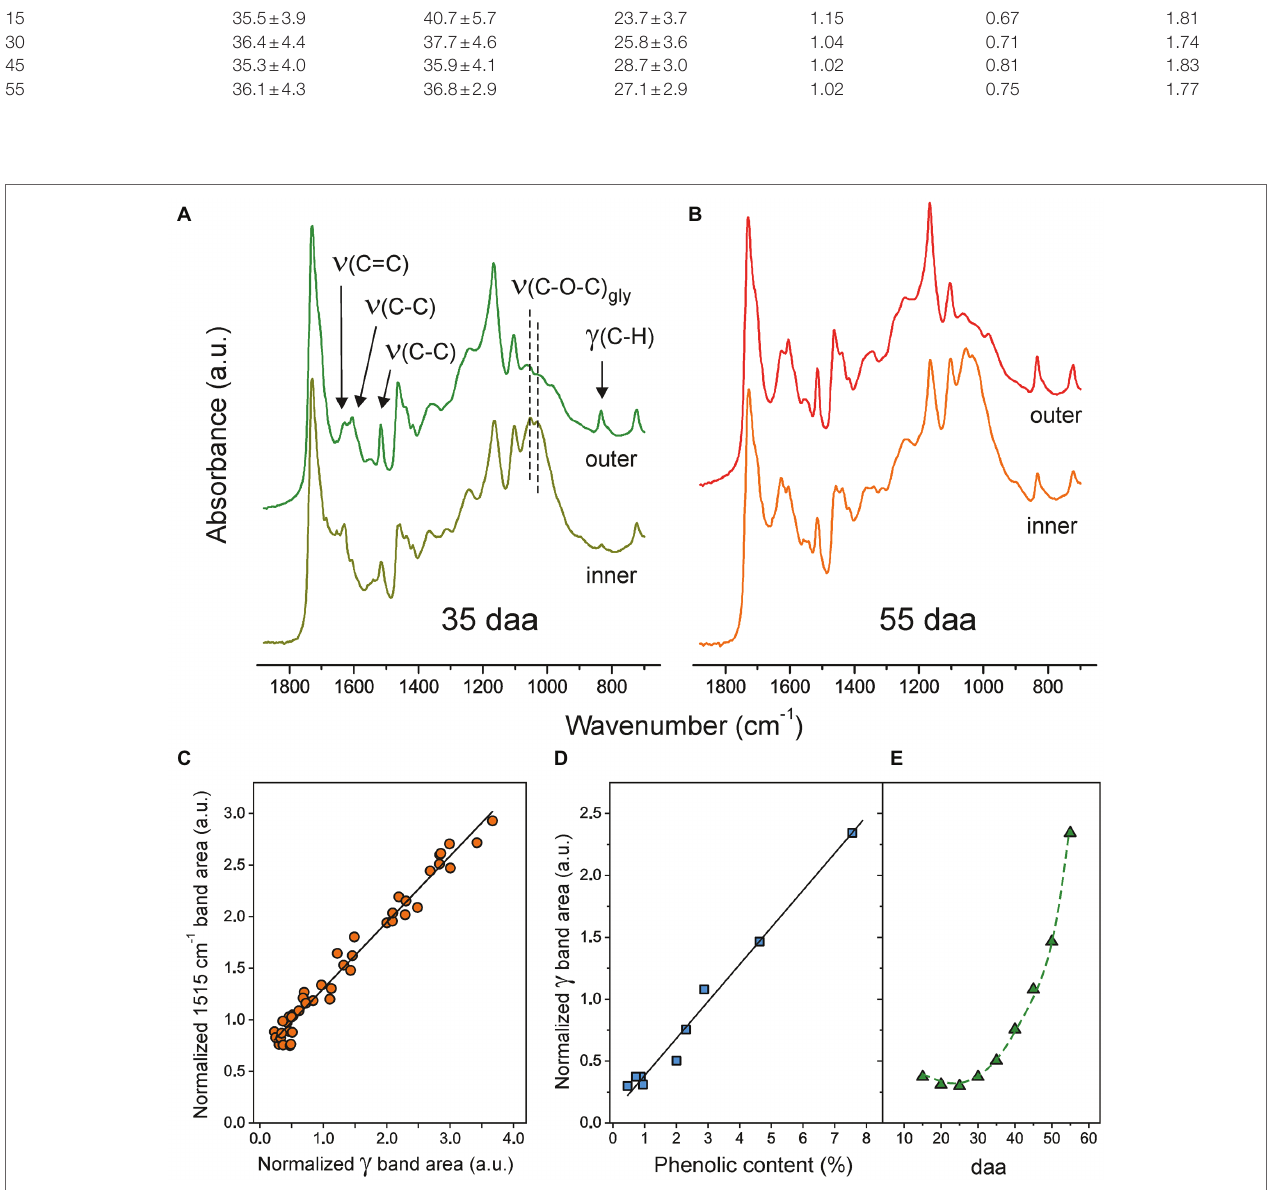
FIGURE 2 | (A) and (B) Normalized ATR-FTIR spectra (700–1875 cm − 1 ) of both sides of Cascada cuticles at 35 and 55 daa, respectively. (C) Relationship between normalized areas of bands at 1515 cm − 1 and ( γ ) at 835 cm − 1 . (D) Correlation between the normalized area of the ( γ ) band and the phenolic content obtained from UV–Vis spectroscopy. (D) Phenolics evolution in Cascada cuticles along fruit development as monitored by the normalized ( γ ) ATR-FTIR